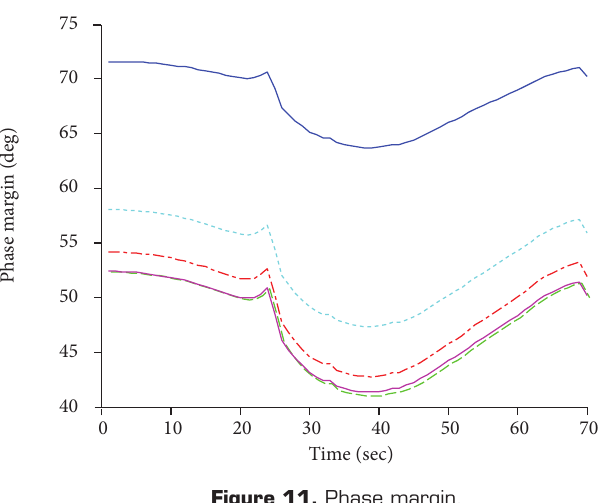
Figure 11. Phase